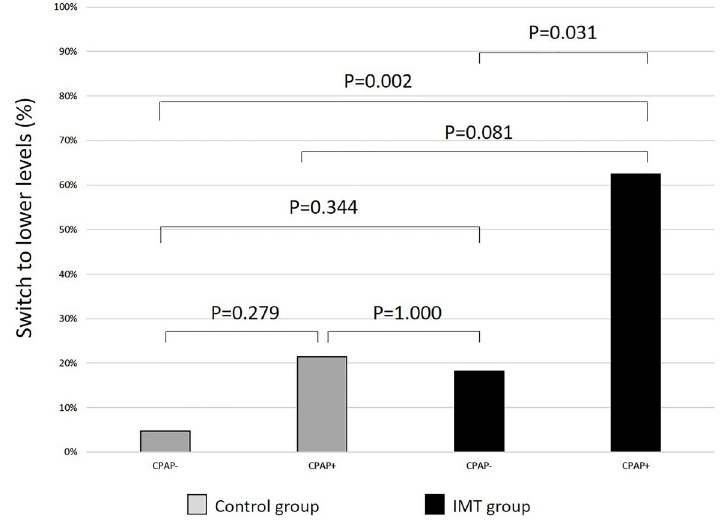
Figure 2. Percent of participants who progressed from the stage of severe obstructive sleep apnea (OSA) to lower levels in the subgroups that did not use continuous positive airway pressure (CPAP – ) and that used CPAP (CPAP + ) in the control group (gray bars) and the inspiratory muscle training (IMT) group (black bars). Differences tested by Friedman ANOVA complemented by Mann-Whitney